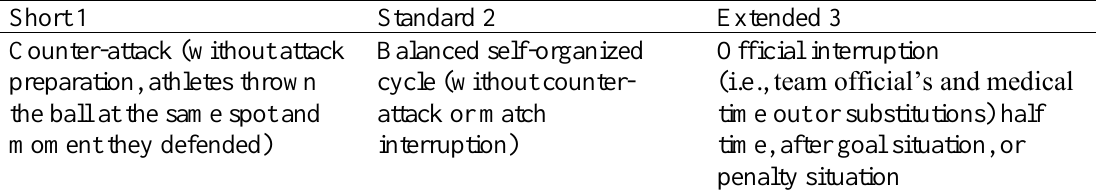
Table 1. Scale of relative quality (Scal-Go) for preceding